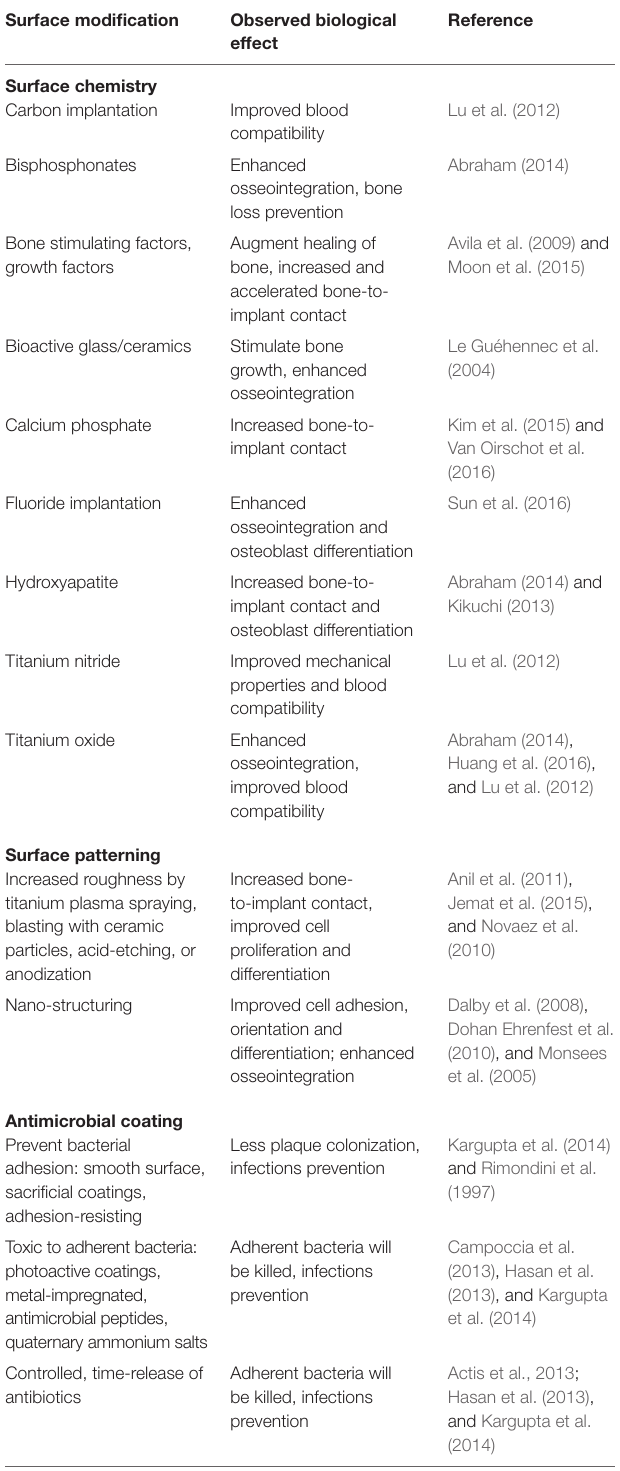
TABLe 1 | Overview on coatings for dental implants that improve osseointegration and/or prevent microbial colonization. Surface